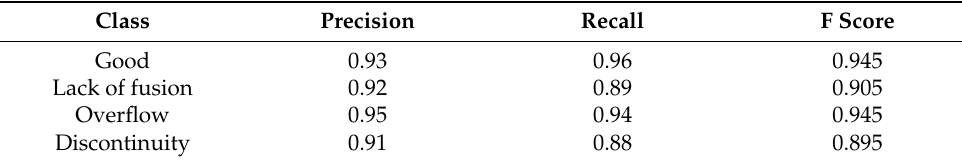
Table 4. Precision, recall, and F score of our model on the test dataset.